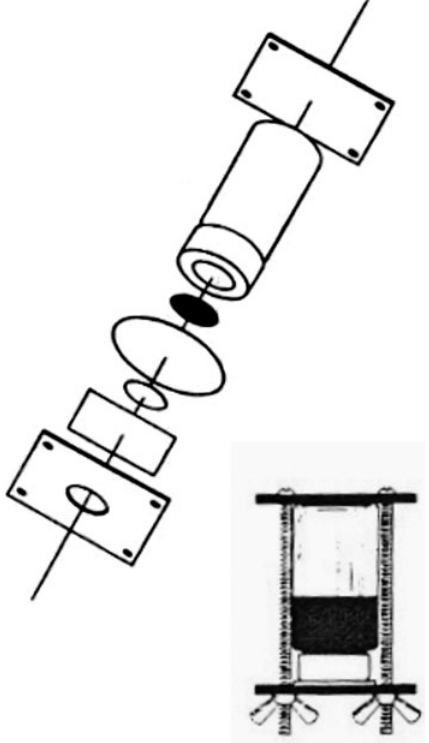
Figure 1 Diagram of the permeation cell (Vo-Dinh and White